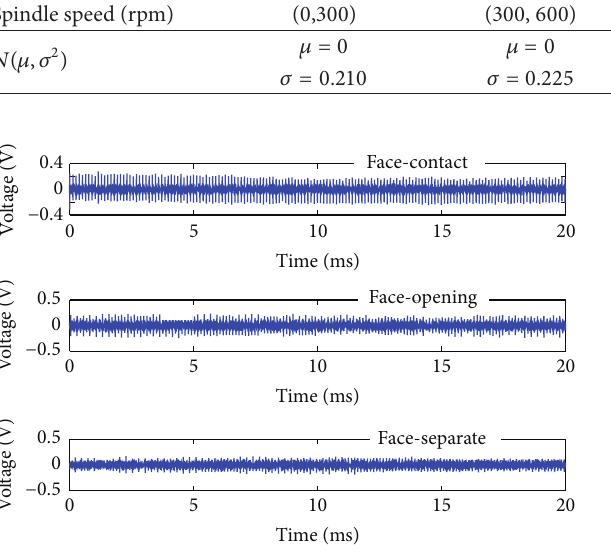
Figure 7: The filtered signals in different contact states.